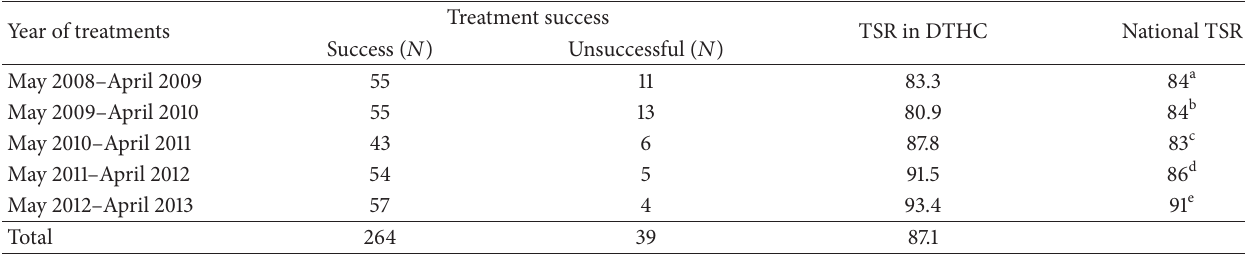
Table 5: Comparison of TSR in Debre Tabor with the national TSR, 2008–2013, 𝑁 = 303 . Year of